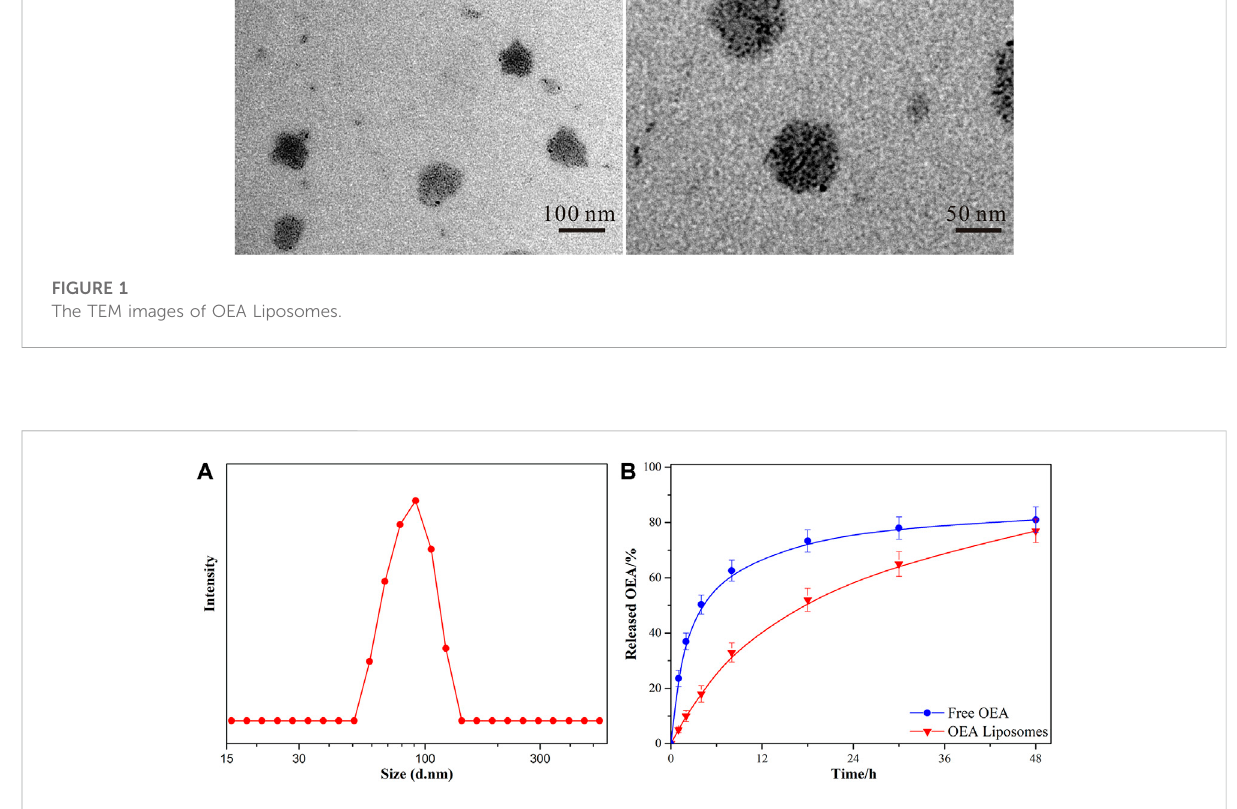
FIGURE 2 The size (A) and in vitro drug release pro fi les (B) of OEA